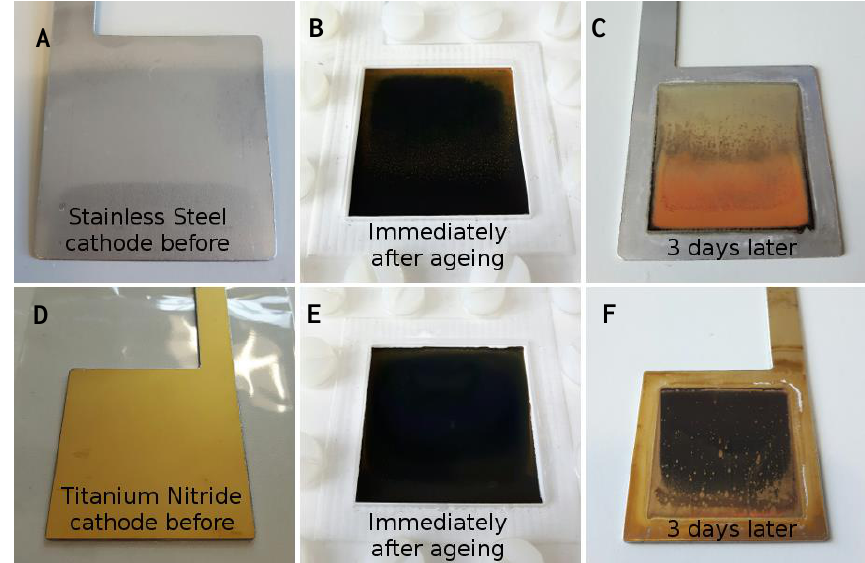
Figure 7. Visual appearance before and after Ageing Protocol A of 316 stainless-steel cathodes both coated in TiN and uncoated. ( A ) is original unaged cathode, ( B ) is immediately after aging, ( C ) is after a further 3 days sitting in 0.5 M NaOH, ( D ) is original unaged TiN coated cathode, ( E ) is immediately after aging, ( F ) is after a further 3 days sitting in 0.5 M NaOH.